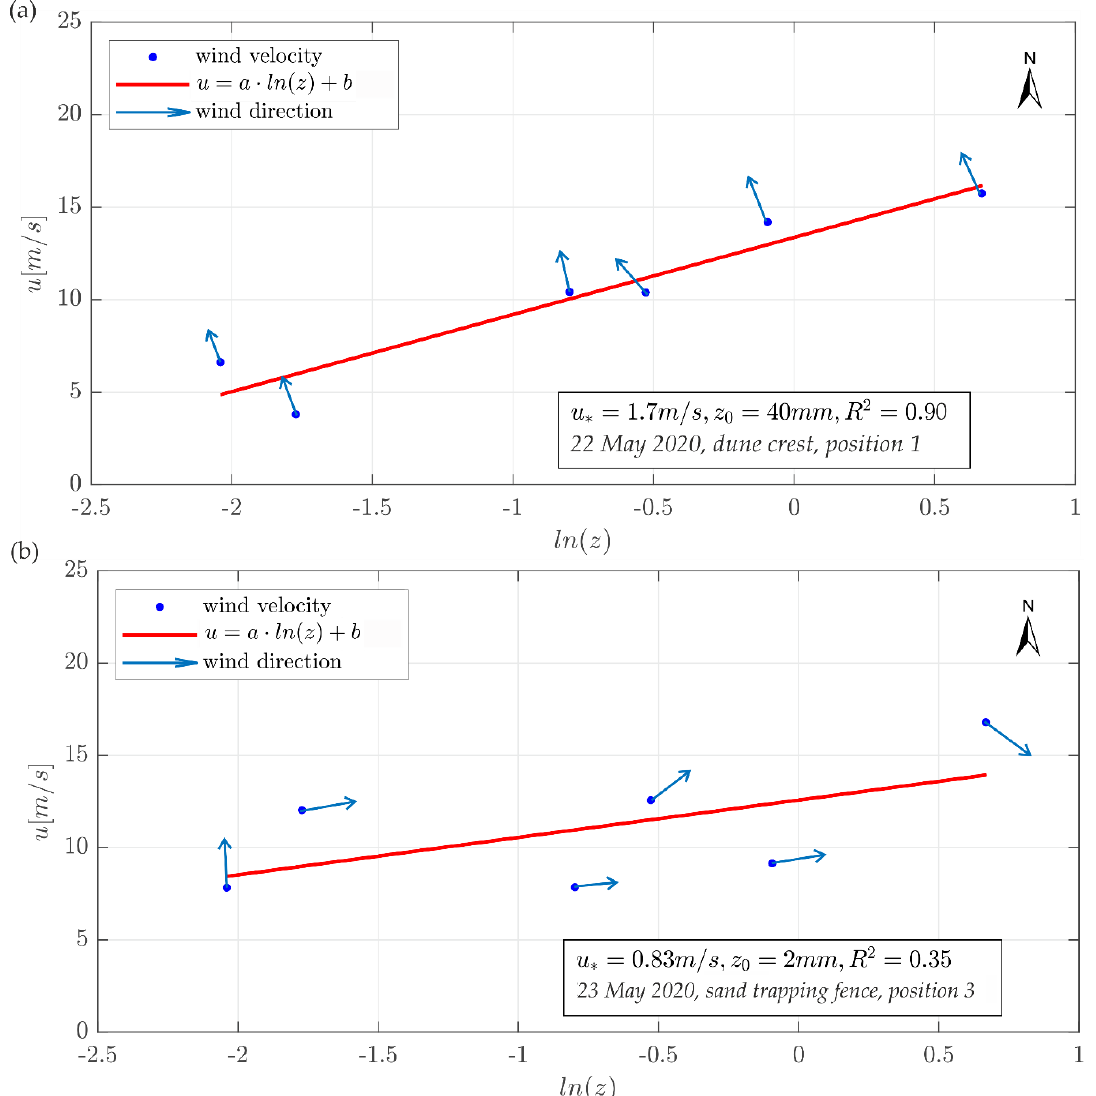
Figure 8. Representative example of a velocity profile to determine the shear velocity and roughness length for the locations ( a ) dune crest and ( b ) sand trapping fence (position 2) on the study site of Langeoog. The blue dots show the measured wind velocity, the blue vectors show the wind direction, and the red line indicates the regression line, see Equation (1).